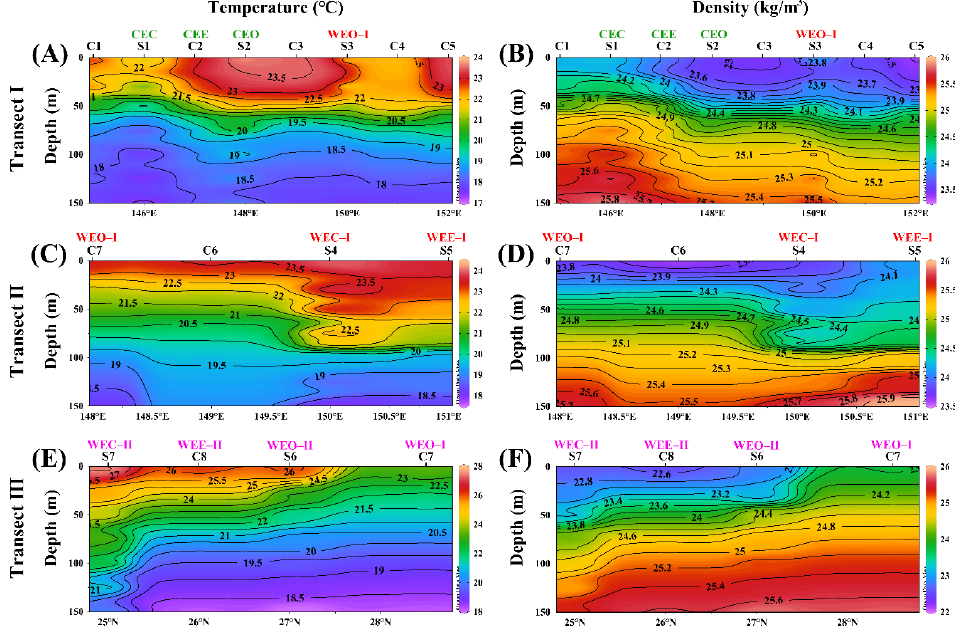
Figure 2. Sectional distribution of the hydrography in the upper 150 m. Distributions of ( A ) temperature, ( B ) density along transect I, ( C ) temperature, ( D ) density along transect II, ( E ) temperature, and ( F ) density along transect III. The stations are denoted at the X axis and are separated into eddy cores, edges, and outside stations at the top (CEC, CEE, WEC–I, WEE–I, WEO–I, WEC–II, WEE–II,